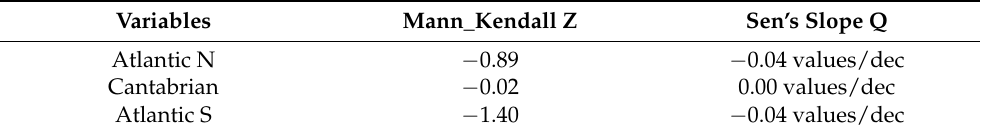
Table 2. Values of the statistic Z of a Mann-Kendall test and Q from a Sen’s slope corresponding to the temporal evolution between 1973 and 2017 of the component scores of each PC.